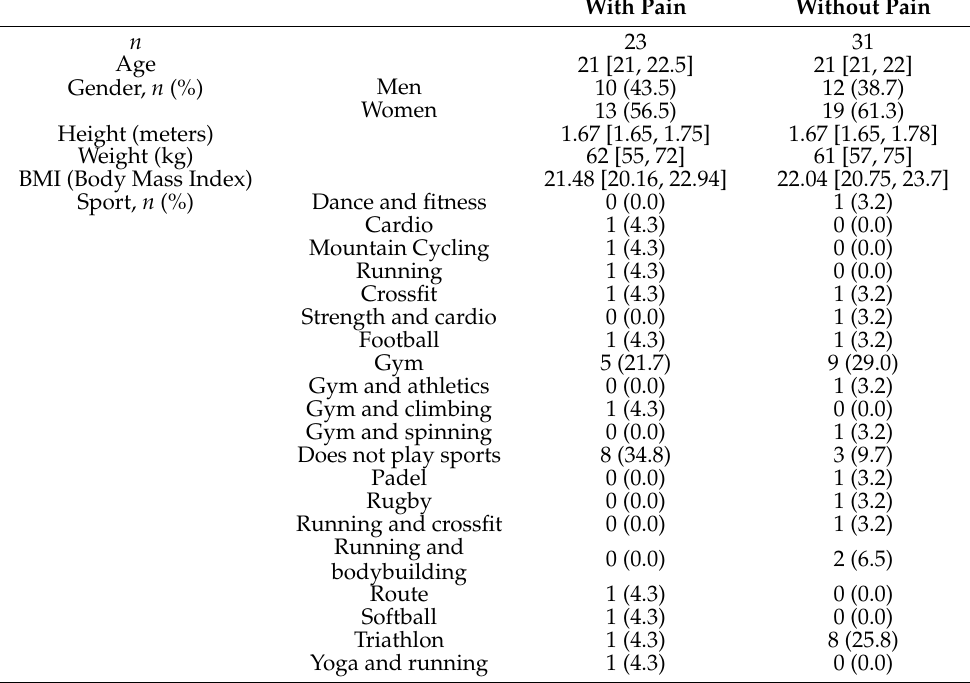
Table 1. Baseline characteristics of